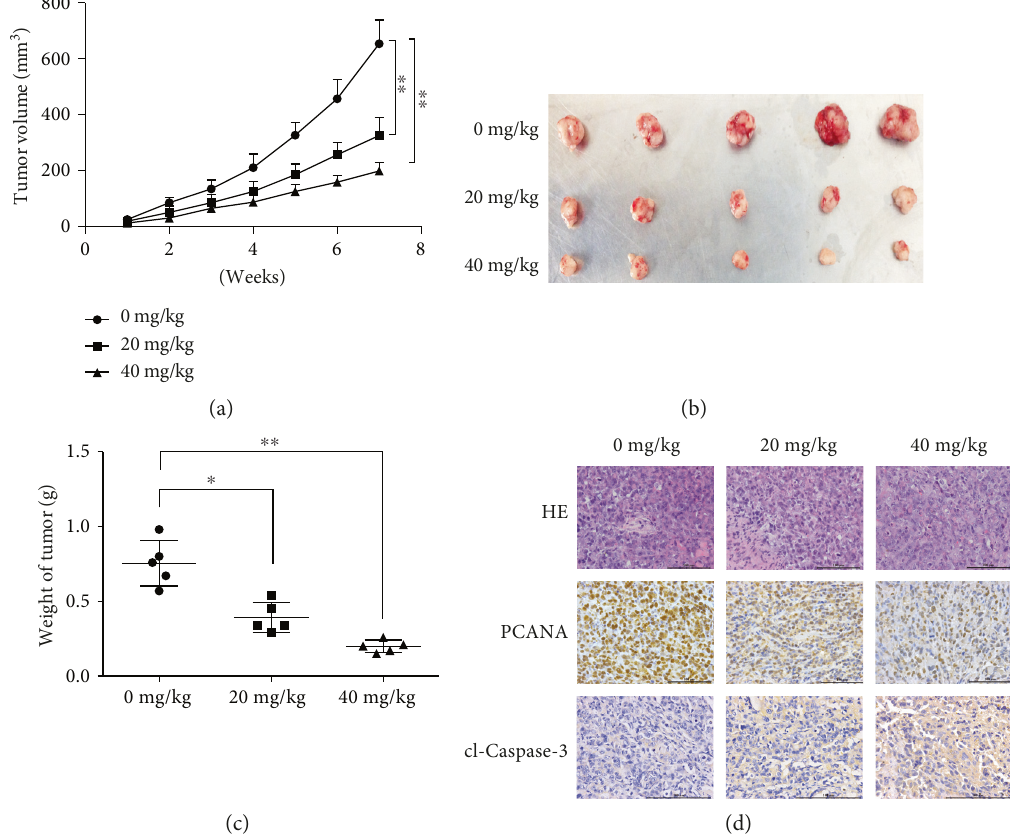
Figure 4: Aloesin inhibits tumor growth in a xenograft model of ovarian cancer. (a) A xenograft model of ovarian cancer was established using SKOV3 cells. Mice from each group were injected with aloesin (20 mg/kg or 40 mg/kg) daily until 7 weeks. Mice without aloesin injection was fed as control. Tumor volumes in each group were calculated and shown. (b) Seven weeks after inoculation, tumors from each group of mice were dissected. (c) Dissected tumors were weighed. The average weight of tumors from each group of mice was calculated. (d) The expression of PCNA and cleaved caspase-3 was detected in xenografts by IHC. ∗ p < 0 05 ; ∗∗ p < 0 01